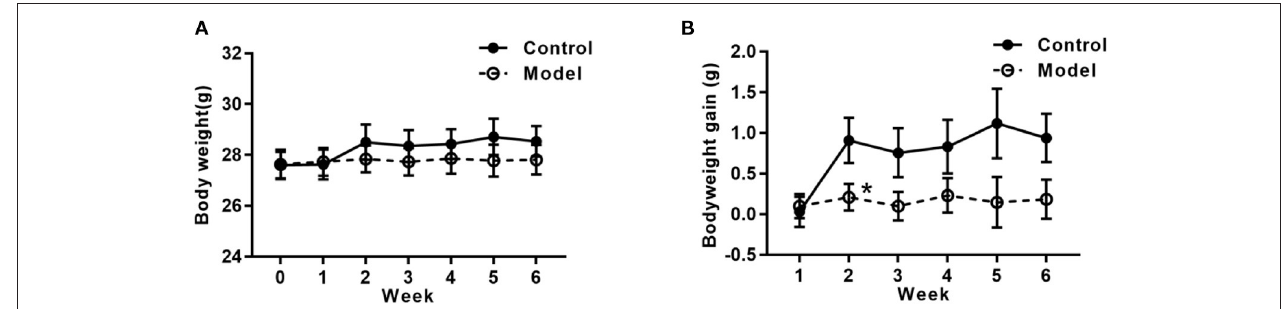
FIGURE 2 | Effects of bilaterally hippocampal injection of STZ on the bodyweight gain in mice. The data are presented as the mean ± SEM, with 13 mice in each group. Although there was no significant difference between groups with regard to the bodyweight (A) , the net bodyweight gain (B) of mice injected by STZ in the model group was lower than that in the control group in the 2nd week. * P < 0.05, compared with the control group.